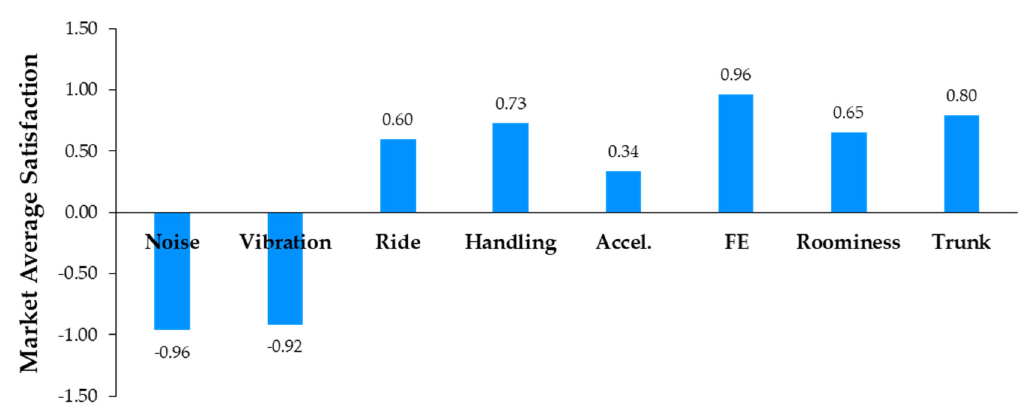
Figure 8. Amount of mentions for each performance aspect during the period from January to June 2019 (before the release of Product D).